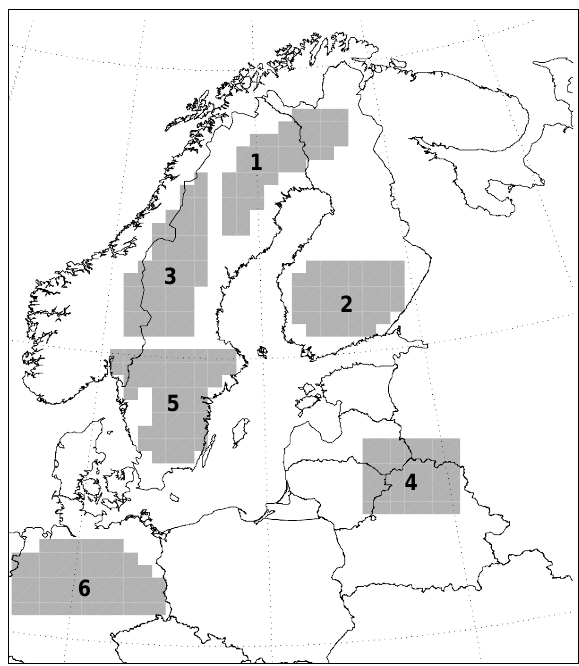
Fig. 2. Map of the six regions discussed in the text and as shown in Figs. 2–9. The regions were selected to cover different bio-climatic zones: the subarctic and boreo-montane zone (region 1), the boreal zone (regions 2 and 3), the boreo-nemoral zone (regions 4 and 5), and to the nemoral zone (region 6).